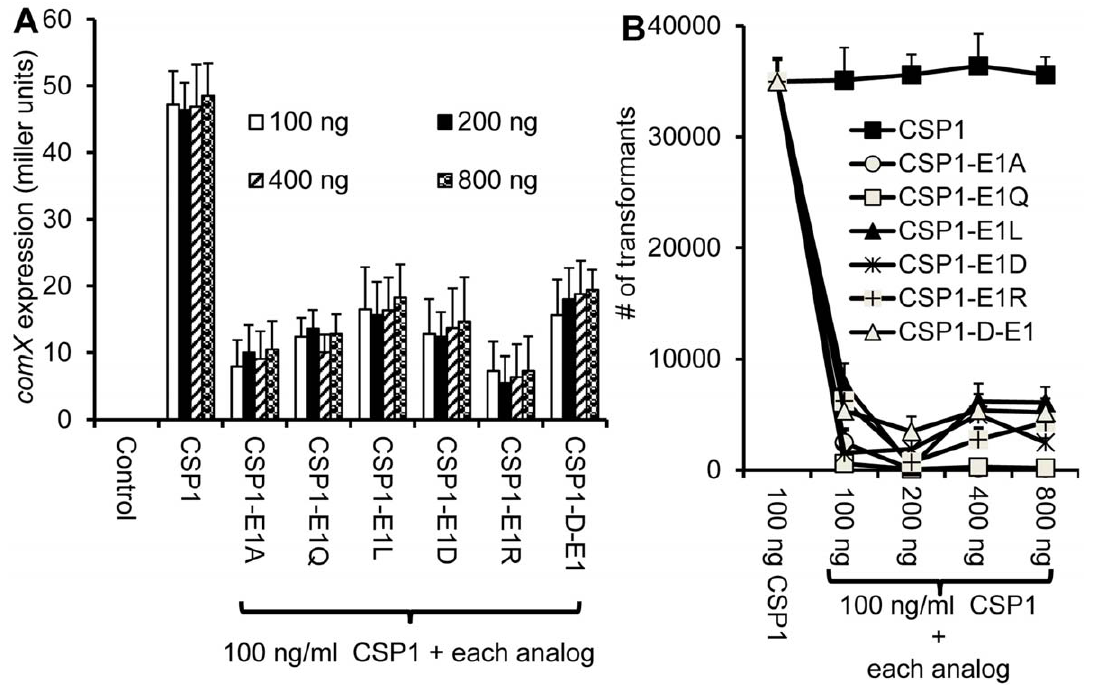
Figure 5. Dose dependent inhibition of comX expression and genetic transformation by CSP1 analogs with substitution at glutamate residue in the first position. (A) CSP1 analogs with substitution at the first glutamate acid competitively inhibit CSP1-mediated induction of comX . D39pcomX::lacZ cells were exposed to 100 ng/ml of CSP1 alone or simultaneously with increasing concentrations of CSP1 analogs. The activity of the comX gene promoter was measured by b -galactosidase activity. Experiments were performed in triplicates and repeated three times. The means 6 SD of one typical experiment are shown. (B) CSP1 analogs with substitution at the first glutamate acid competitively inhibit the ability of CSP1 to induce genetic transformation. Genetic transformation was performed using the rpsL gene. Transformants were selected on THB agar containing 100 m g/ml streptomycin. Experiments were performed in triplicates and repeated three times. The means 6 SD of one typical experiment are shown.